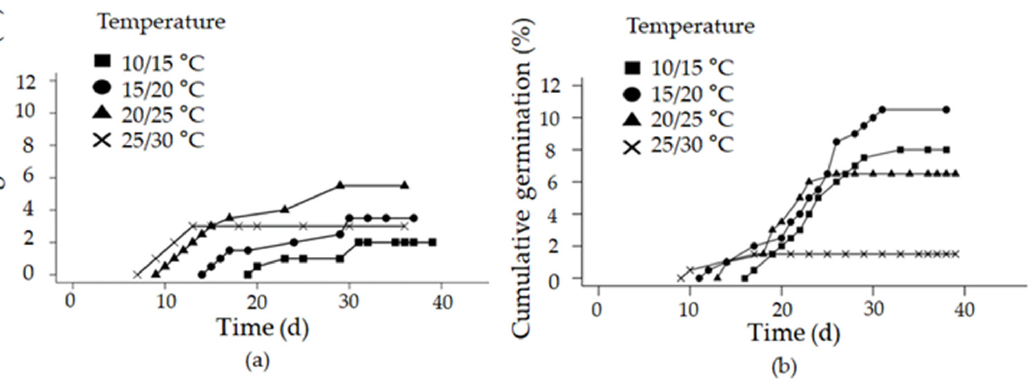
Figure 4. Cumulative germination percentages under optimal treatment: ( a ) Abies beshanzuensis (14-day cold stratification) and ( b ) Abies ziyuanensis (28-day cold stratification).